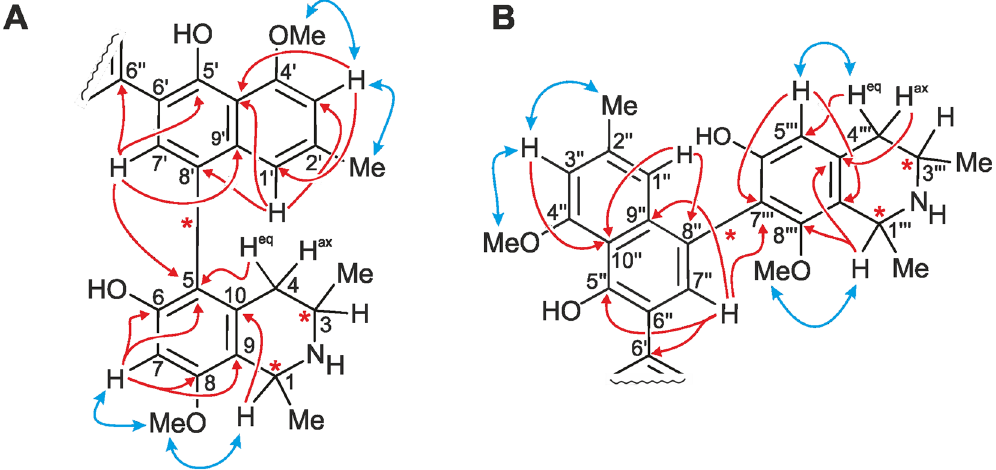
Figure 2. HMBC (red arrows) and ROESY (blue arrows) interactions indicative of the constitutions of the southeastern ( A ) and the northwestern ( B ) moieties of